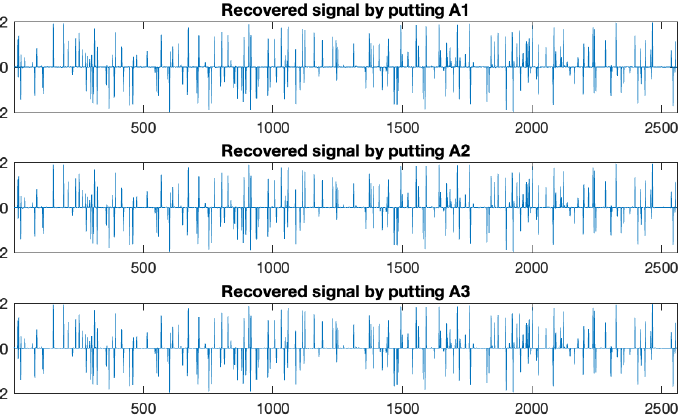
Figure 14. The recovered signal with m = 210 by A1 (503 Iter, CPU = 1.6346), A2 (474 Iter, CPU = 1.5908), and A3 (427 Iter, CPU = 1.3930), respectively.